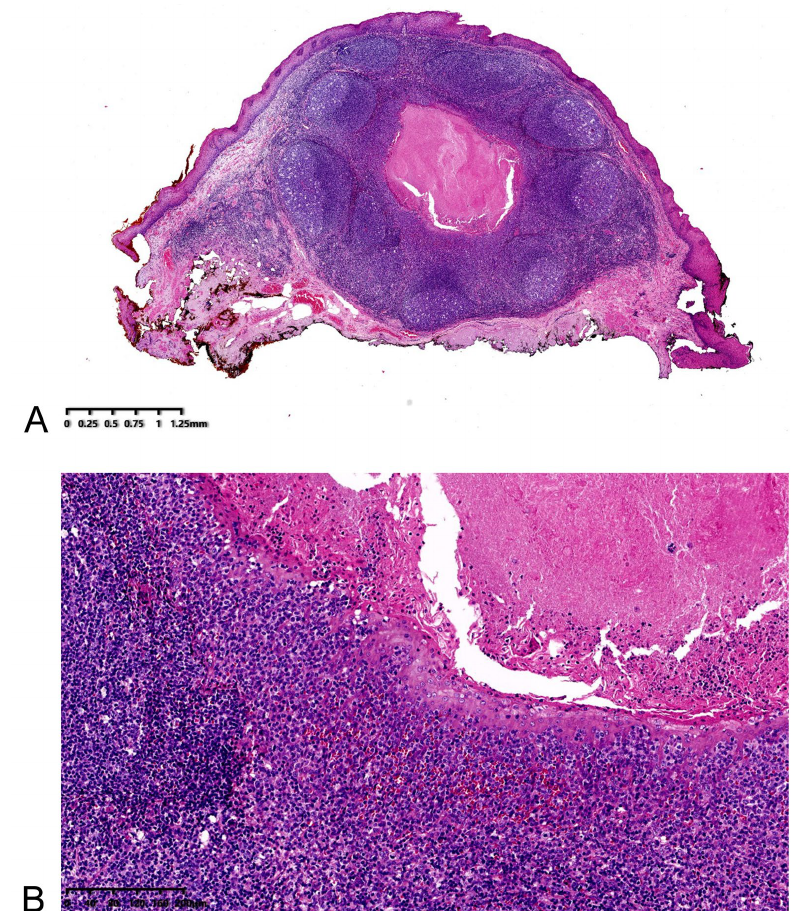
Figure 3. ( A ) At lower power, the lesion shows a well-defined location between the lamina propria and the submucosa. ( B ) High power displays lymphoepithelial crypts lined by stratified squamous mucosa with infiltrating lymphocytes and histocytes.